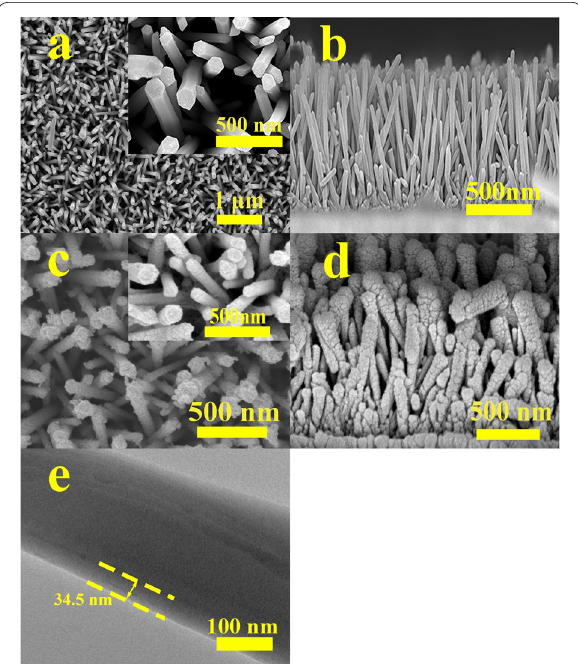
Fig. 1 a Top-view SEM images of ZnO NRs (inset is a local amplification of the ZnO NRs). b Cross-section diagram of ZnO NRs. c Top-view SEM images of ZnO NRs/PEDOS (inset is a local amplification of the ZnO NRs/PEDOS). d Cross-section diagram of ZnO NRs/PEDOS. e TEM image of the ZnO NRs/PEDOS core–shell heterostructure